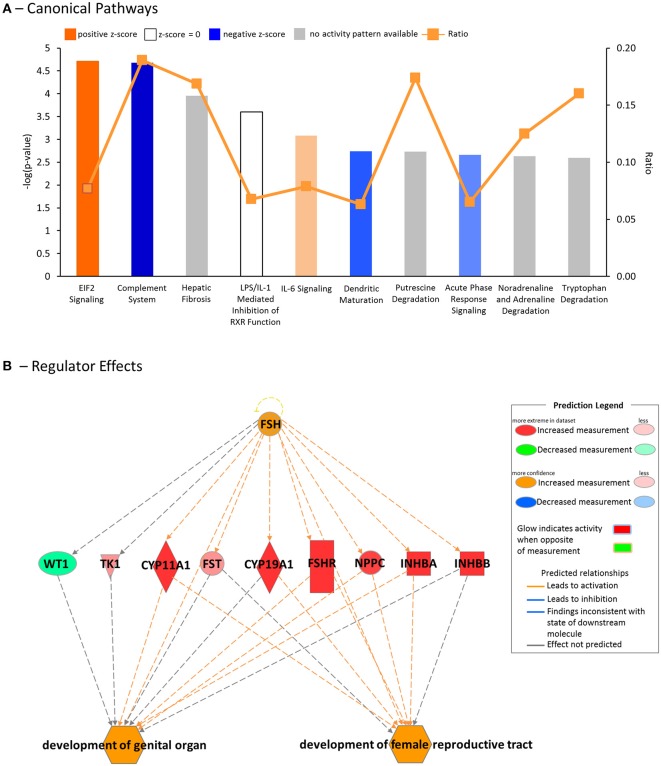
Downstream effects and upstream regulators, as predicted by the Ingenuity Pathway Analysis (IPA) platform. (A) Top canonical pathways affected by GOAT deletion. (B) Regulator Effects analysis, featuring the top predicted upstream regulator, Follicle Stimulating Hormone (FSH), its connection to the differentially expressed genes (DEGs) in the dataset and their influence on the top biological functions, likely to be affected by GOAT deletion.